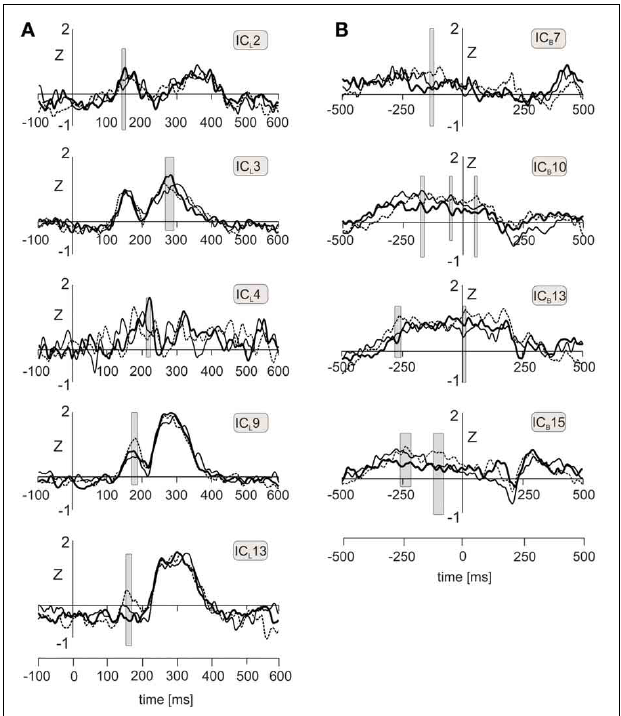
FIGURE 3 | (A) Time courses of five independent components of LEPs, labeled IC L 2, IC L 3, IC L 4, IC L 9, and IC L 13, during viewing neutral (solid line), positive (dot line), and negative (bold line) emotional pictures. Gray shaded rectangles indicate the time intervals during which one-way ANOVA for repeated measures achieved statistical significance ( P < 0 . 05). (B) Time courses of four independent components (IC B 7, IC B 10, IC B 13, IC B 15) showing statistically significant differences between neutral (solid line), positive (dot line), and negative (bold line) emotional pictures during peri-stimulus interval. Gray shaded rectangles indicate intervals showing statistically significant effects of emotional pictures in one-way ANOVA for repeated